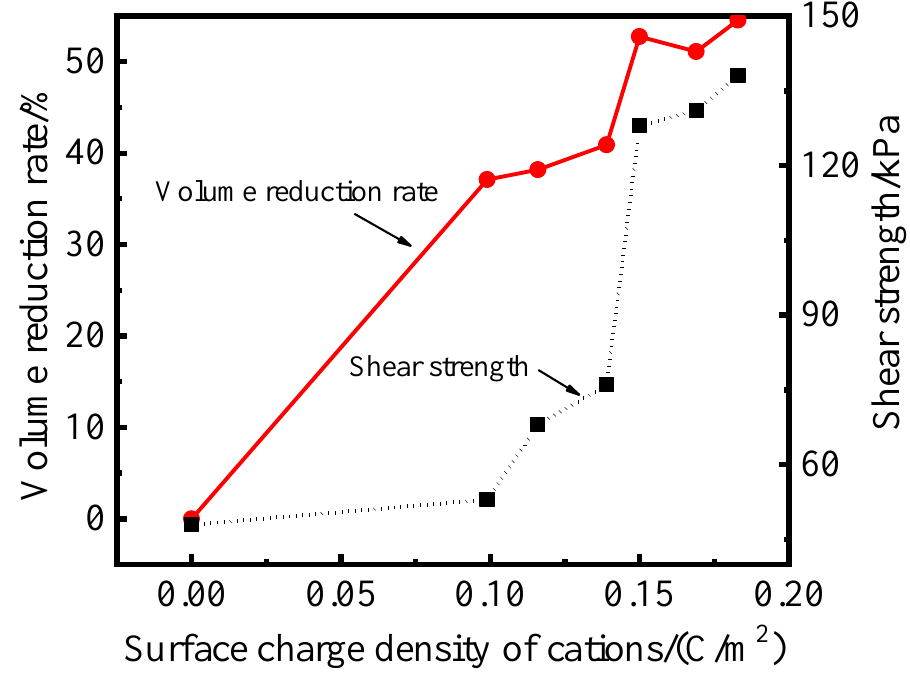
Figure 6. Relationship between the expansion volume, shear strength and surface charge density of cations.